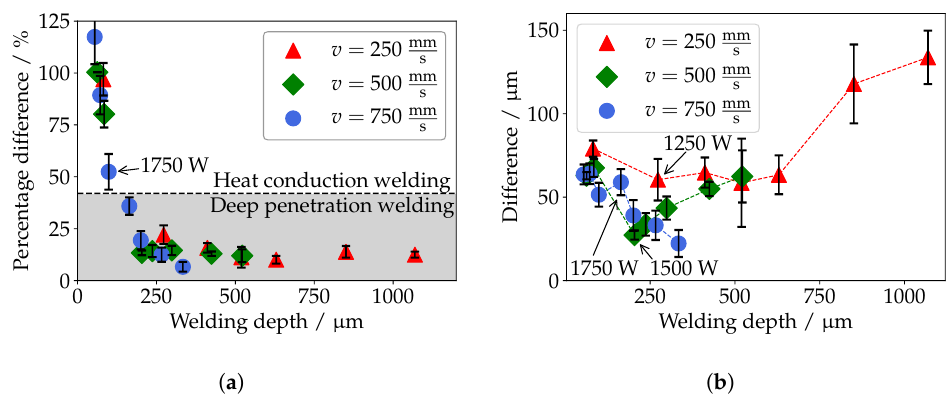
Figure 8. ( a ) Percentage difference between measured capillary depth and welding depth as function of the welding depth, white: heat conduction welding, grey: deep penetration welding; ( b ) absolute difference between measured capillary depth and welding